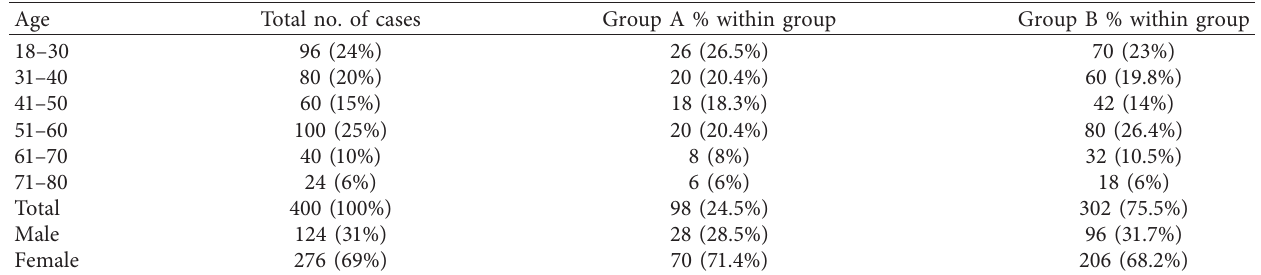
Table 1: Comparison of age and sex distribution of symptomatic cholelithiasis and comparison of group A and B patients number. Age Total no. of cases Group A % within